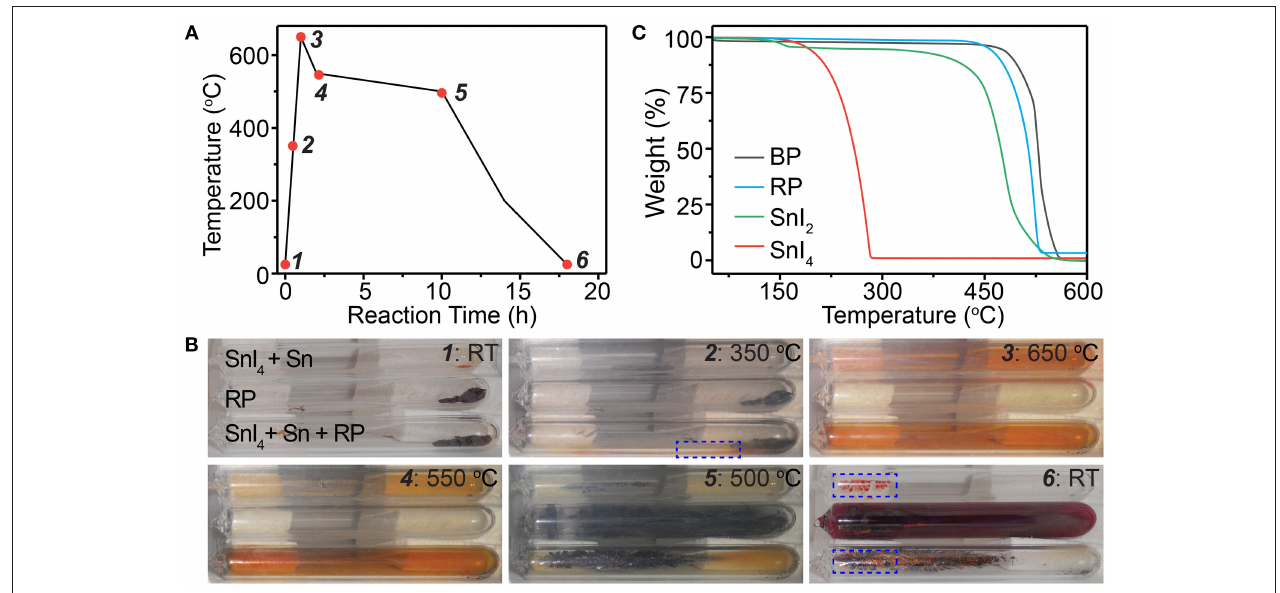
FIGURE 3 | (A) Typical time dependent temperature profile for synthesizing BP crystals and (B) corresponding in situ photos taken during the synthesis. The red dots in the profile indicate the stages when the photos are taken. (C) Thermogravimetric profiles of different compounds. Note that RT and RP denote room temperature and red phosphorus, respectively.